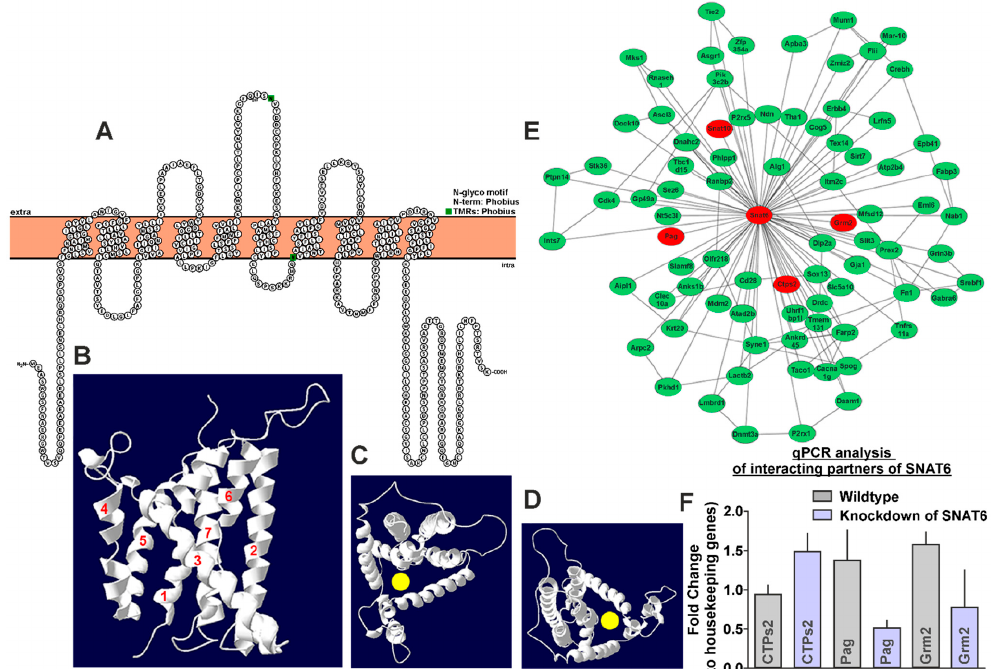
Figure 1. Predicted structure of SNAT6 and analysis of proteins influencing or being influenced by Scheme 6. ( A )Topology prediction of SNAT6 is used to visualize the transmembrane segments using the software ‘Protter’ that enables interactive protein feature visualization and integration of experimental proteomic data. ( B ) Predicted 3D structure of SNAT6 with 7 transmembrane segments is obtained using the Swiss-Model, where a structurally known arginine-agmatine antiporter protein is used as template. ( C ) and ( D ) The top-views of SNAT6 exhibit a possible substrate pore (marked in yellow) for transport. ( E ) ARACNE generated network of proteins influencing or being influenced by SNAT6. SNAT6 and four other proteins namely CTP Synthase 2 (CTPs2), Phosphate activated glutaminase (Pag), Glutamate metabotropic receptor 2 (Grm2) and Snat10 are marked red and were chosen for further analysis. ( F ) qPCR analysis revealed upregulation of CTPs2, and downregulation of Pag and Grm2 in the immortalized embryonic mouse hypothalamic cell line where SNAT6 was knocked down using specific siRNA. The qPCR experiments were performed 2–3 times on separate batches of cell line and the data were normalized for cell number differences between untreated control cells seeded on the same set of plates. An unpaired t-test with 95% confidence interval was performed showing significant downregulation for Pag and Grm2 ( p <